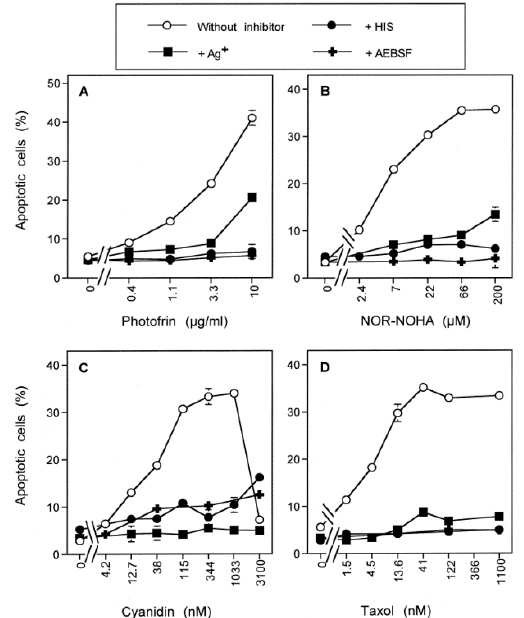
Figure 9. Central role of aquaporin-mediated cooperation for intercellular ROS/RNS signaling after catalase inactivation. 12,500 MKN-45 cells per assay (96 well tissue culture cluster) were treated with either the indicated increasing concentrations of the photosensitizer photofrin ( A ), the arginase inhibitor NOR-NOHA ( B ), cyanidin ( C ) or taxol ( D ). The assays remained either without inhibitors or received 2 mM of the singlet oxygen scavenger histidine (“+HIS”), the aquaporin inhibitor Ag + , or the NOX1 inhibitor AEBSF. Assays under ( A ) were first illuminated at room temperature with visible light for 20 min and then further incubated for 3.5 h before the percentages of apoptotic cells were determined. Assays under ( B – D ) were incubated for 3.5 h and then the percentages of apoptotic cells were determined. The results confirm that direct treatment with singlet oxygen ( A ) or generation of tumor cell-derived singlet oxygen after modulation the endogenous NO level (Bauer, 2015) caused apoptosis induction. In all four systems, apoptosis induction was dependent on the action of singlet oxygen, the activity of NOX1 and the action of aquaporins. These findings demonstrate that the concept of aquaporin-mediated cooperation with ROS-mediated apoptosis-inducing signaling is relevant for a broad variety of treatments that are based on inactivation of tumor cell protective catalase. Statistical analysis. Apoptosis induction by the indicated inducers, as well as inhibition of apoptosis induction by AEBSF, histidine and Ag+ were highly significant ( p < 0.001).